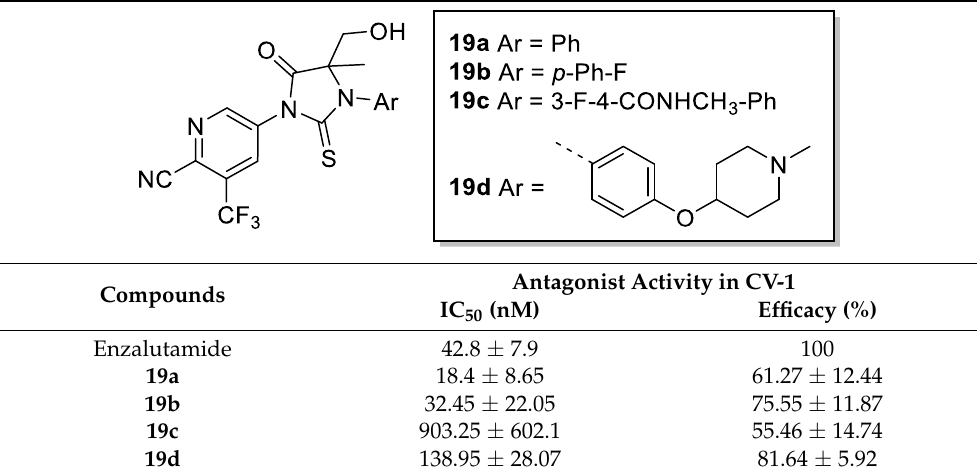
Table 3. Bioactivity of compounds 19a-d .